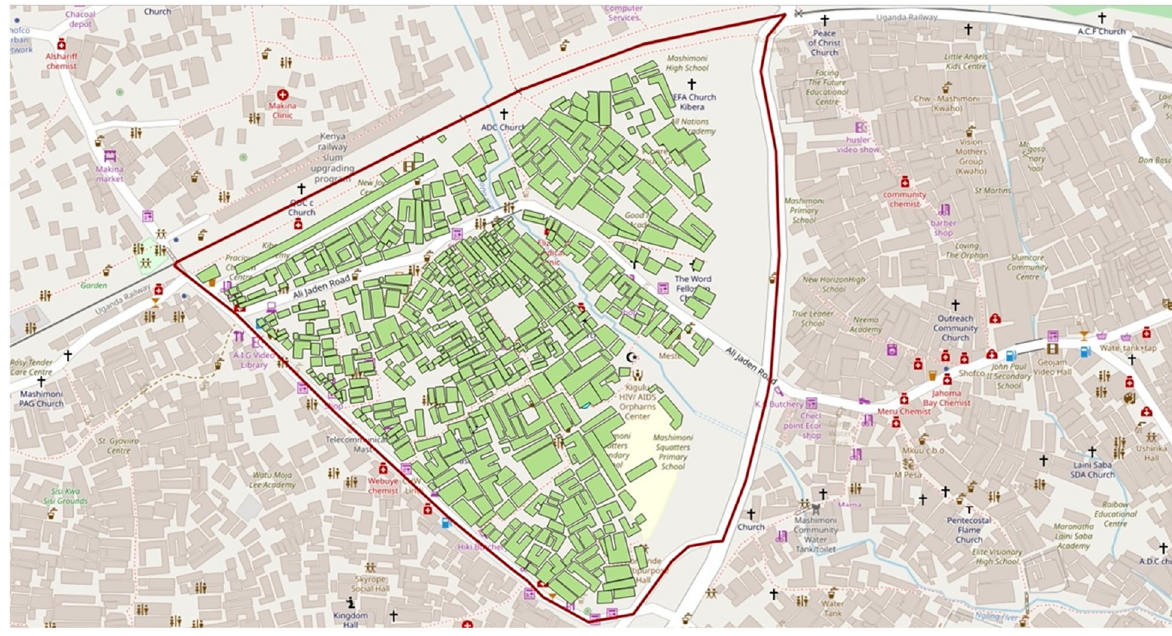
Fig 2. The focal triangle of the